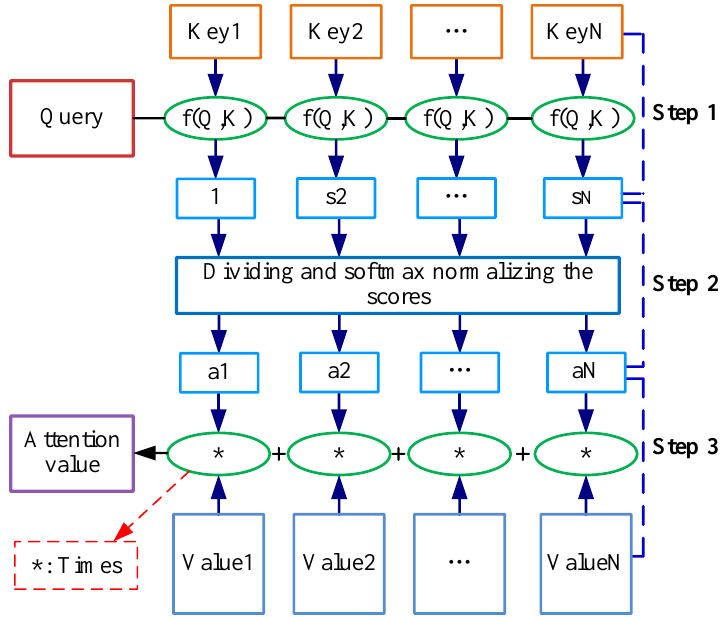
Figure 8. The flowchart of the self-attention